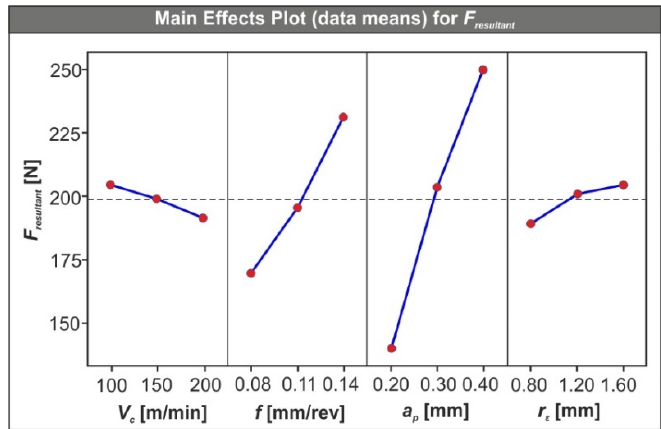
Figure 8. Main effects plot for the resultant machining force.